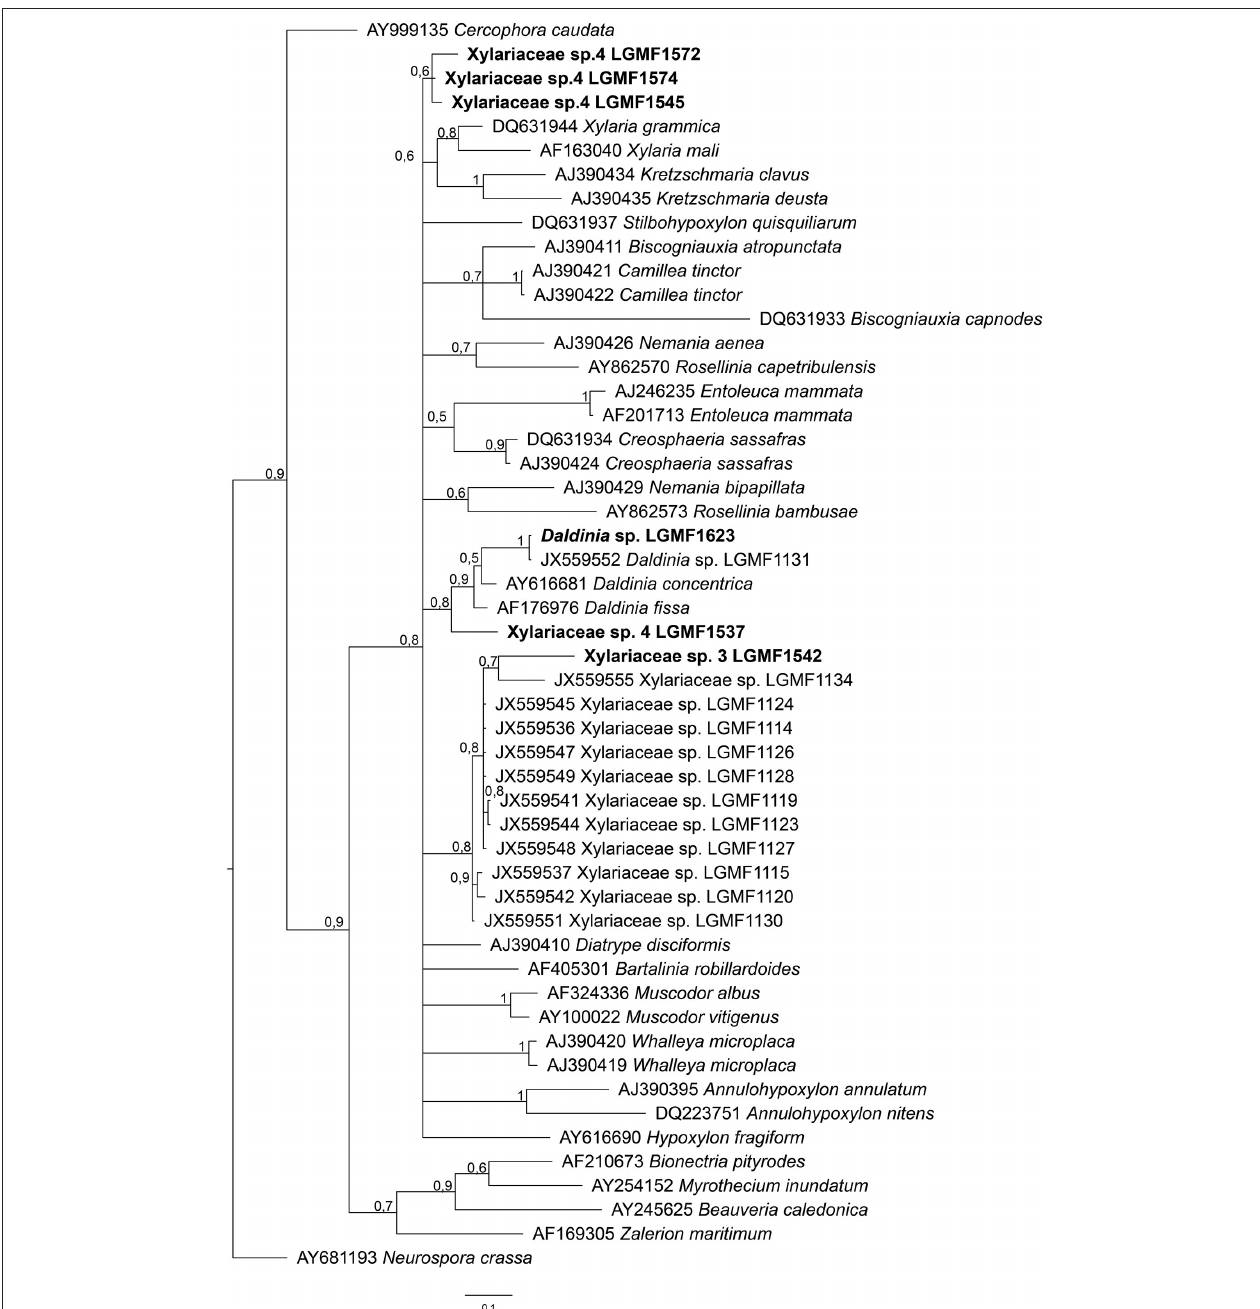
FIGURE 2 | Bayesian phylogenetic tree based on ITS partial sequence of LGMF1572, LGMF1574, LGMF1545, LGMF1613, LGMF1537, and LGMF1542 (bold) sequence of genera of Xylariaceae family. The data matrix had 52 taxa and 416 characters. The tree was rooted to: Neurospora crassa (AY681193). Scale bar shows 0.1 changes and Bayesian posterior probability values are indicated at the nodes. T: type strain.